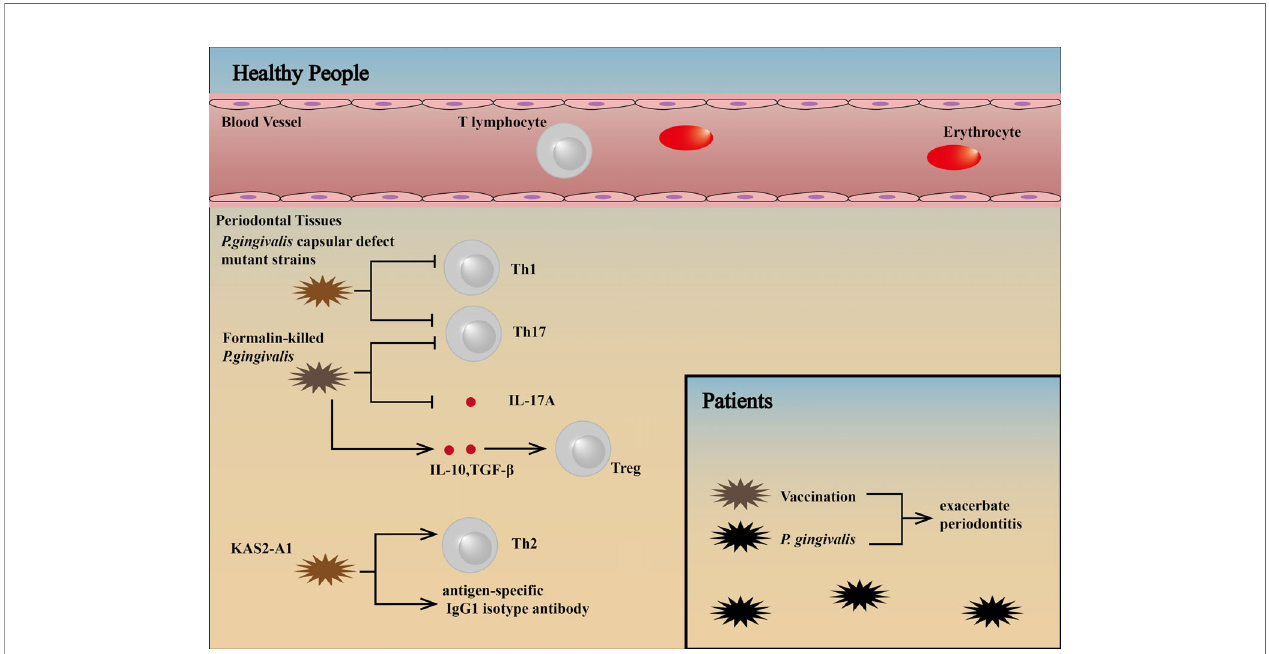
FIGURE 5 | In fl uence of vaccination against pathogens in patients and healthy people. P. gingivalis capsular defect mutant strains cause reduced loss of alveolar bone because of non-expression of RANKL and a decrease in Th1/Th17 cytokines, Th1/Th17 lymphocytes, and osteoclasts (156). Subcutaneously vaccination with formalin-killed P. gingivalis can result in upregulation of Tregs through the production of IL-10 and TGF- b , downregulation of Th17 cells and IL-17A production and inhibition of lymphocyte proliferation (157). P. gingivalis -speci fi c in fl ammatory immune responses can be protected by therapeutic vaccination with a chimera (KAS2- A1) immunogen targeting the major virulence factors of the bacterium, the gingipain proteinases. This protection is characterized by an antigen-speci fi c IgG1 isotype antibody and Th2 cell response (158). Patients with P. gingivalis -associated periodontitis have higher threshold levels of pathogens in the subgingival plaque and exhibit an in fl ammatory immune response. Therefore, therapeutic vaccination may exacerbate in fl ammation and bone resorption in these patients (89,